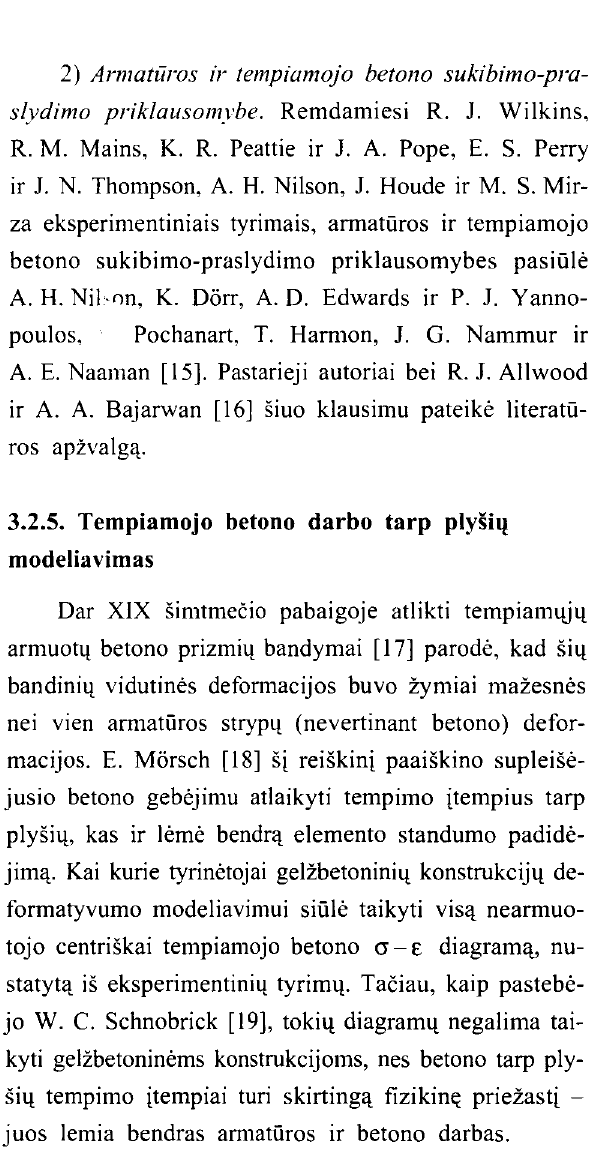
nems konstrukcijoms